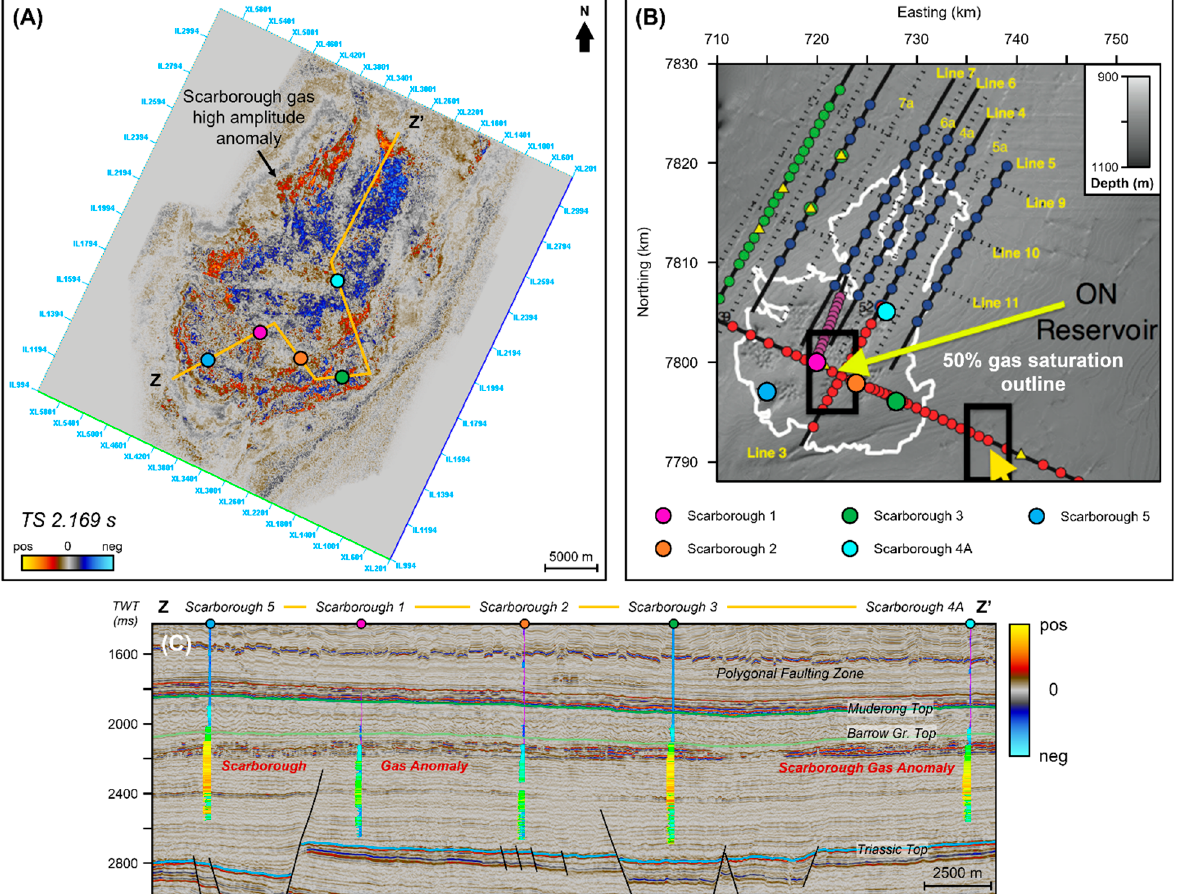
Figure 5. ( A ) A horizontal time slice taken at 2.169 s through the Scarborough seismic survey displaying the high amplitude anomaly of the Scarborough gas field. ( B ) A CSEM study by Ray et al. [4] where they defined the 50% gas saturation outline within the Scarborough gas field (modified after Ray et al. [4]). ( C ) Interpreted arbitrary seismic section highlighting the Scarborough gas anomalies, key horizons, and wells used for this study.